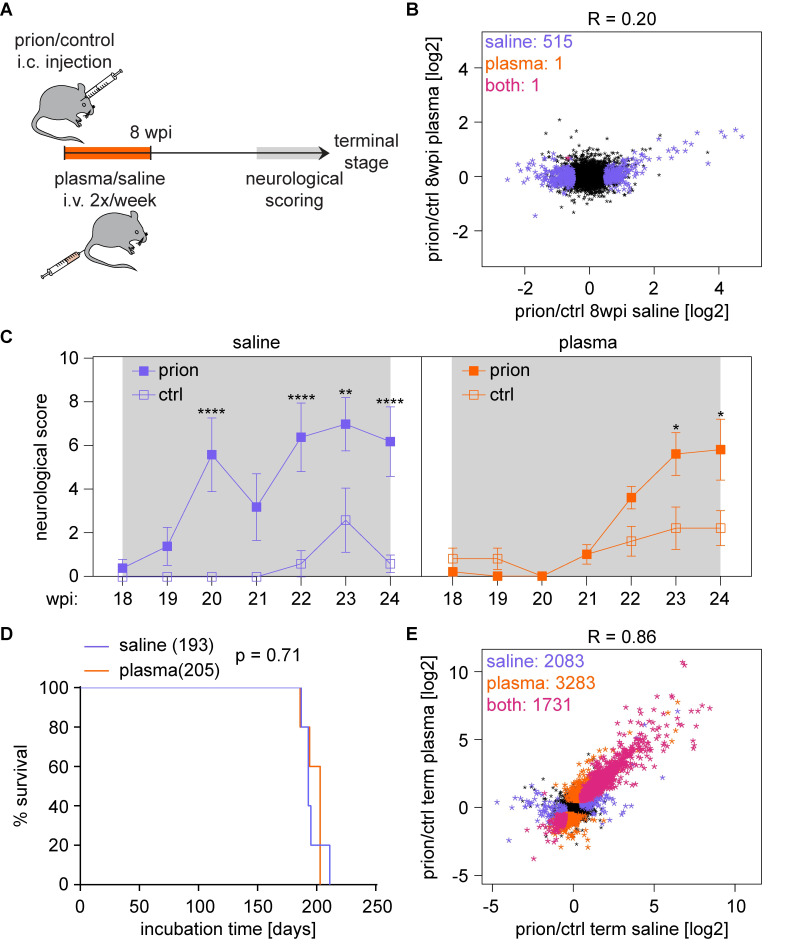
Young plasma treatment ameliorates prion disease progression.A Time points of prion inoculation, plasma treatment, neurological scoring and sample analysis. B Scatter plot comparing the log2FC of expressed genes in plasma and saline treated prion-inoculated mice at 8 wpi. Differentially expressed genes (|log2FC| > 0.5 and FDR < 0.05) are colored in purple (saline; n = 515) and orange (plasma; n = 1). C Plot displaying the neurological score of saline and plasma-treated mice from 18 wpi until the terminal stage. Shown is the mean neurological score +/- SEM (**p<0.01; ***p<0.001; ****p<0.001; two-way ANOVA followed by Tukey’s multiple comparison test comparing prion vs control samples at each time point). D Survival curves of mice that were treated for 8 weeks with saline or plasma after prion inoculation. Shown is the % survival compared to days post inoculation (dpi). The median survival of plasma treated mice did not change (p = 0.71; log-rank Mantel-Cox test). E Scatter plot comparing the log2FC of expressed genes in plasma and saline treated prion-inoculated mice at the terminal stage. Differentially expressed genes (|log2FC| > 0.5 and FDR < 0.05) are colored in purple (saline; n = 2,083), orange (plasma; n = 3,283) or pink (both; n = 1,730).